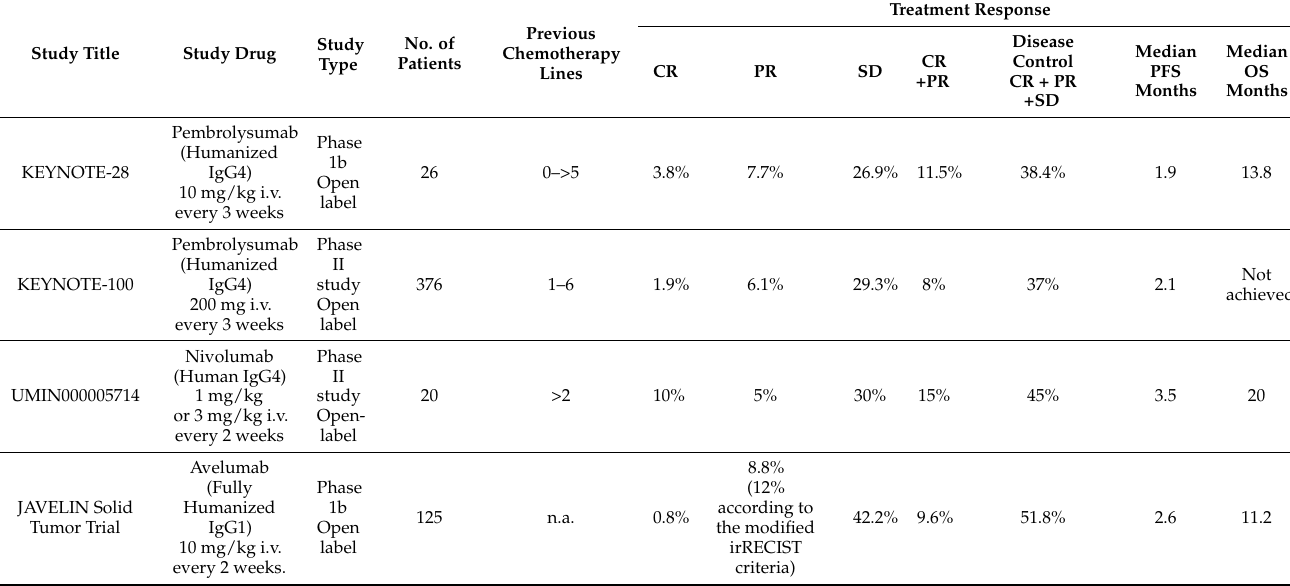
Table 1. Phase I or phase II studies in patients with recurrent ovarian